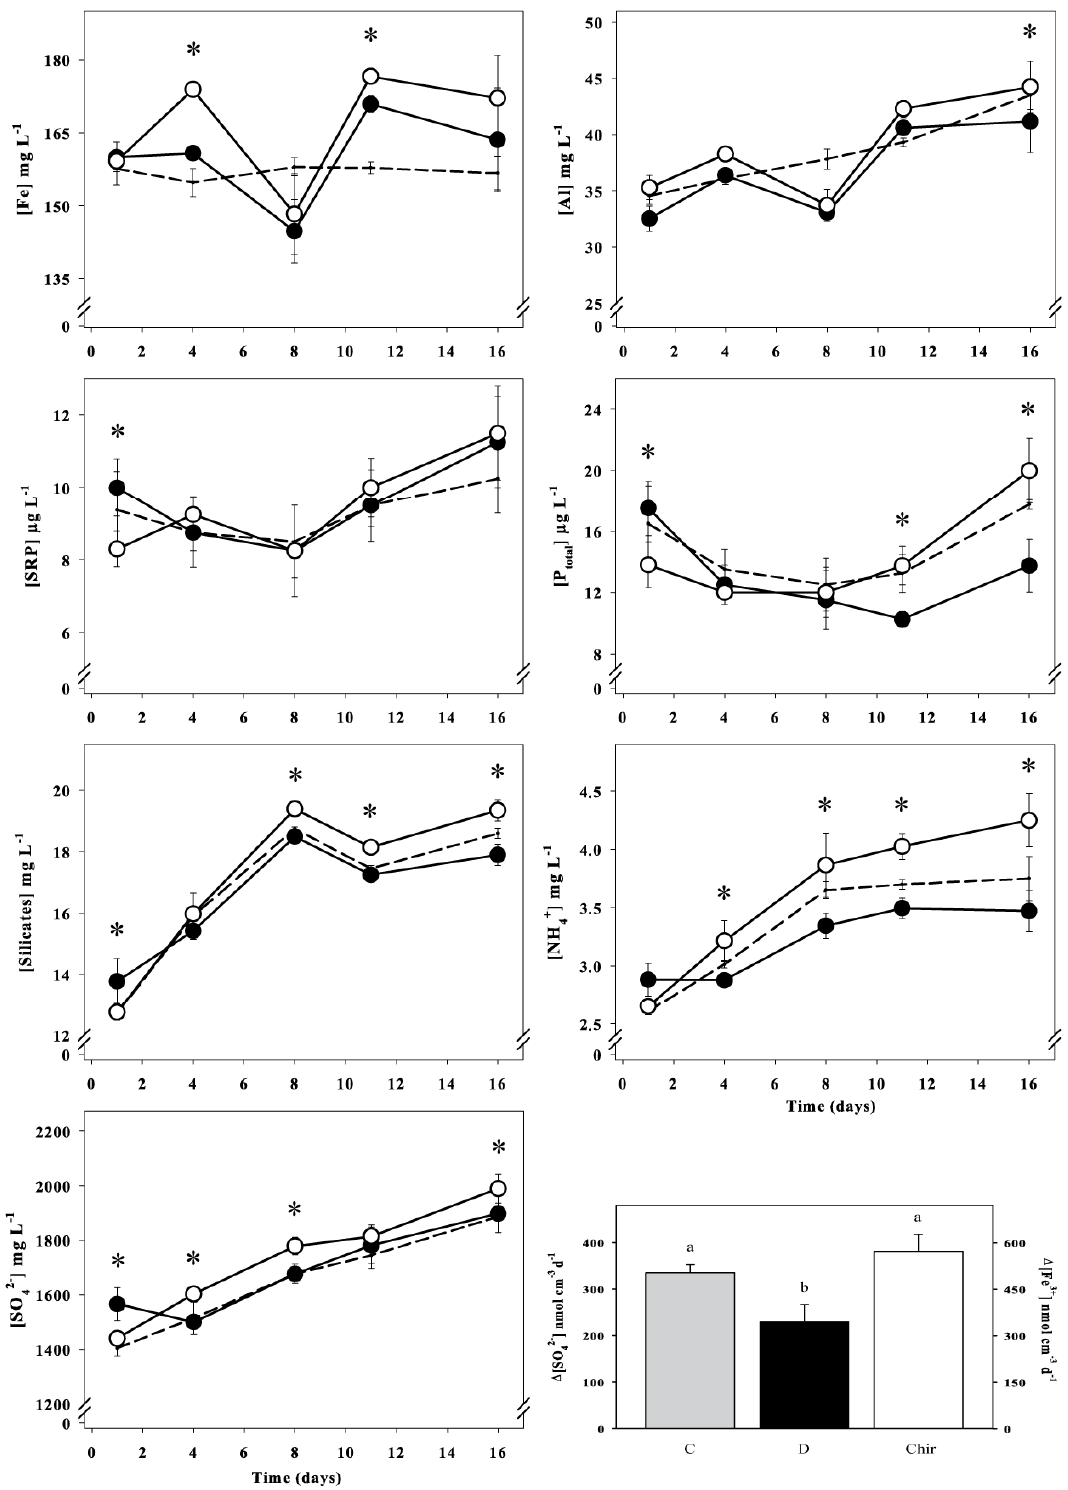
Fig. 2. Temporal variation of the concentrations of the main dissolved chemical species in the water column in the different treatments (Control: C, - - - -; Defaunated: D, – • – ; with chironomids: Chir, – ◦ –). Means ± SD ( N = 4). Stars indicate significant differences between D- and Chir- treatments at each time of sampling. The bar chart represents the potential jarosite dissolution expressed as a net rate of sulfate and hypothetical ferric iron release. Means ± SD ( N = 4). Different letters indicate significant differences between